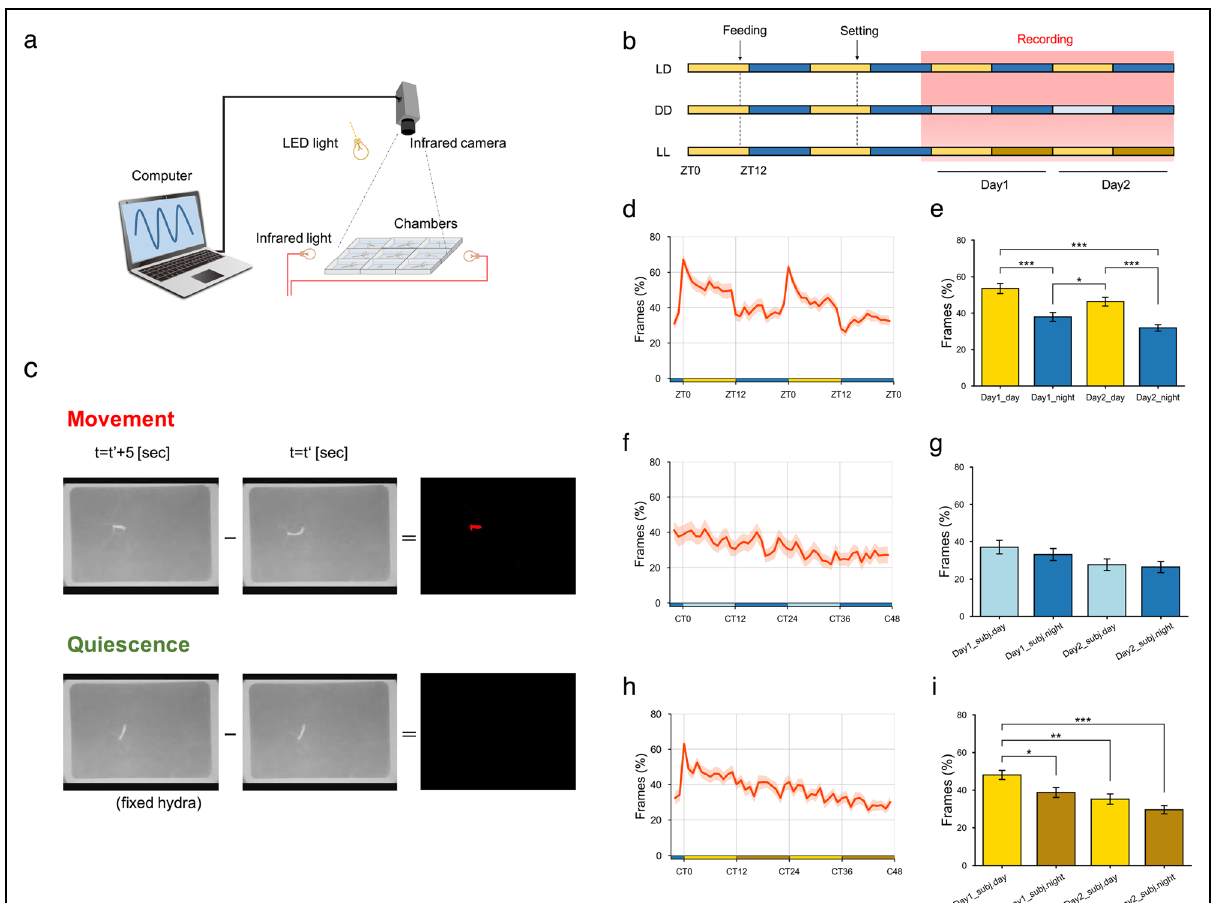
Fig. 1 Hydras exhibit behavioral day-night variation a Behavioral recording system. Hydras were placed into rectangular chambers and illuminated with infrared light. The movements of the hydras were captured using an infrared camera. b Experimental scheme of behavior analysis under LD 12:12 cycles, DD and LL conditions. Hydras fasted for 24 h were placed into the chamber at ZT10 (setting). Light blue indicates subjective day under DD condition and dark yellow indicates subjective night under LL condition. c Frame subtraction analysis. Upper panel: movement of a hydra between two frames was detected as red (t = t ’ + 5 and t = t ’ ). Lower: no movement was detected when a fixed hydra was captured and analyzed. d , e Percentage of frames in which movement was detected during daytime and nighttime under LD 12:12 cycles ( n = 27). f , g Percentage of frames in which movement was detected under DD condition ( n = 26). h , i Percentage of frames in which movement was detected under LL condition ( n = 27). The orange lines and shaded areas around the lines show the mean and the SEM, respectively. The bars indicate the SEM. * P < 0.05, ** P < 0.01, *** P < 0.001, one-way ANOVA, Tukey post-hoc test. P > 0.05 for all comparisons in g (under DD)